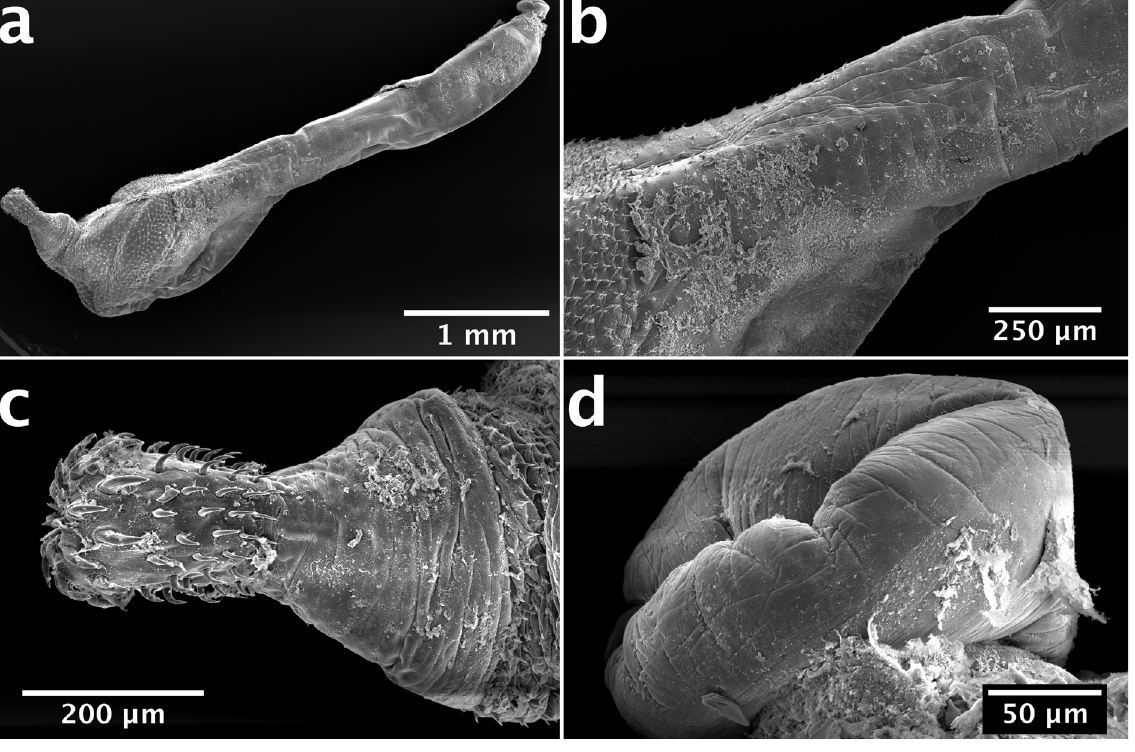
Fig. 7. SEM micrographs of Corynosoma strumosum from grey seals, Halichoerus grypus , in the Swedish Baltic Sea. a . ♂, whole worm, ventro-lateral view, from the Bothnian Sea, Uppland, Östhammar. b . Ventral spination on the hind-trunk of a ♂ restricted to one-third of its length only. c . Proboscis of a ♂, lateral view, showing the spineless neck and the arrangement of the hooks. d . Posterior end of a ♂ showing the extended copulatory